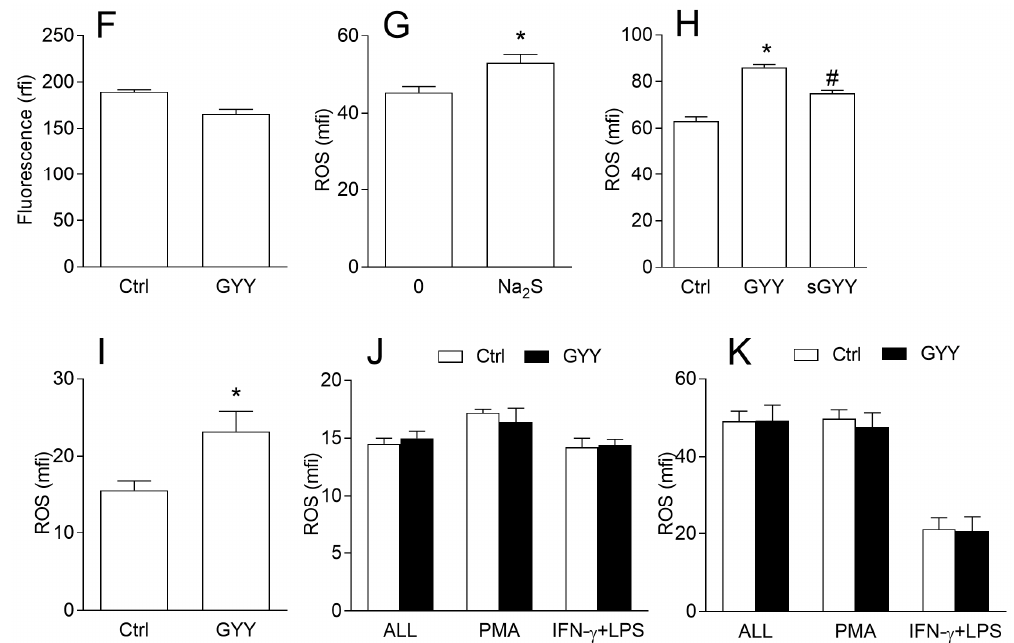
Figure 3. Effects of GYY4137 (GYY) on reactive oxygen species (ROS) production in BV2 cells. BV2 cells were cultivated in the presence of DMSO (Ctrl) as the vehicle or GYY (200 µ M). ( A ) BV2 cells were treated with IFN- γ and LPS and DMSO or GYY for 24 h, stained with DHR, and stimulated with phorbol 12-myristate 13-acetate (PMA) for 90 min (ALL), or they were treated with DMSO or GYY for 24 h, stained with DHR, and stimulated with PMA or IFN- γ and LPS (IFN- γ + LPS) for 90 min. Subsequently, cytofluorimetry was performed. ( B ) Same as A, except that incubation lasted for 1 h instead of 24 h. ( C ) Representative DHR plots from ( B) . ( D ) BV2 cells were treated with DMSO or GYY for the indicated time periods, stained with DHR, stimulated with PMA, and cytofluorimetry was performed. ( E ) BV2 cells were treated with IFN- γ and LPS and DMSO or GYY and analyzed by the real-time cell analyzer. Representative plot is provided. ( F ) DMSO or GYY were mixed with DHR in a cell-free system and fluorescence was detected on a fluorimeter. ( G ) BV2 cells were treated with Na2S (200 µ M) or were untreated (0) for 60 min, stained with DHR, and stimulated with PMA for 90 min. Subsequently, cytofluorimetry was performed. ( H ) BV2 cells were treated with DMSO or GYY for 60 min, stained with DCFDA, and stimulated with PMA for 90 min. Subsequently, cytofluorimetry was performed. ( H ) Same as B (PMA), with additional treatment with “spent” GYY4137 (sGYY). ( I ) same as B (PMA), except that BV2 cells were stained with DCFDA ( J ). Same as B, except that mouse macrophages were used. ( K ) Same as B, except that rat macrophages were used. Data are presented as mean + SD from at least three independent experiments. * p < 0.05 refers to Ctrl or 0; # p < 0.05 refers to difference between GYY and